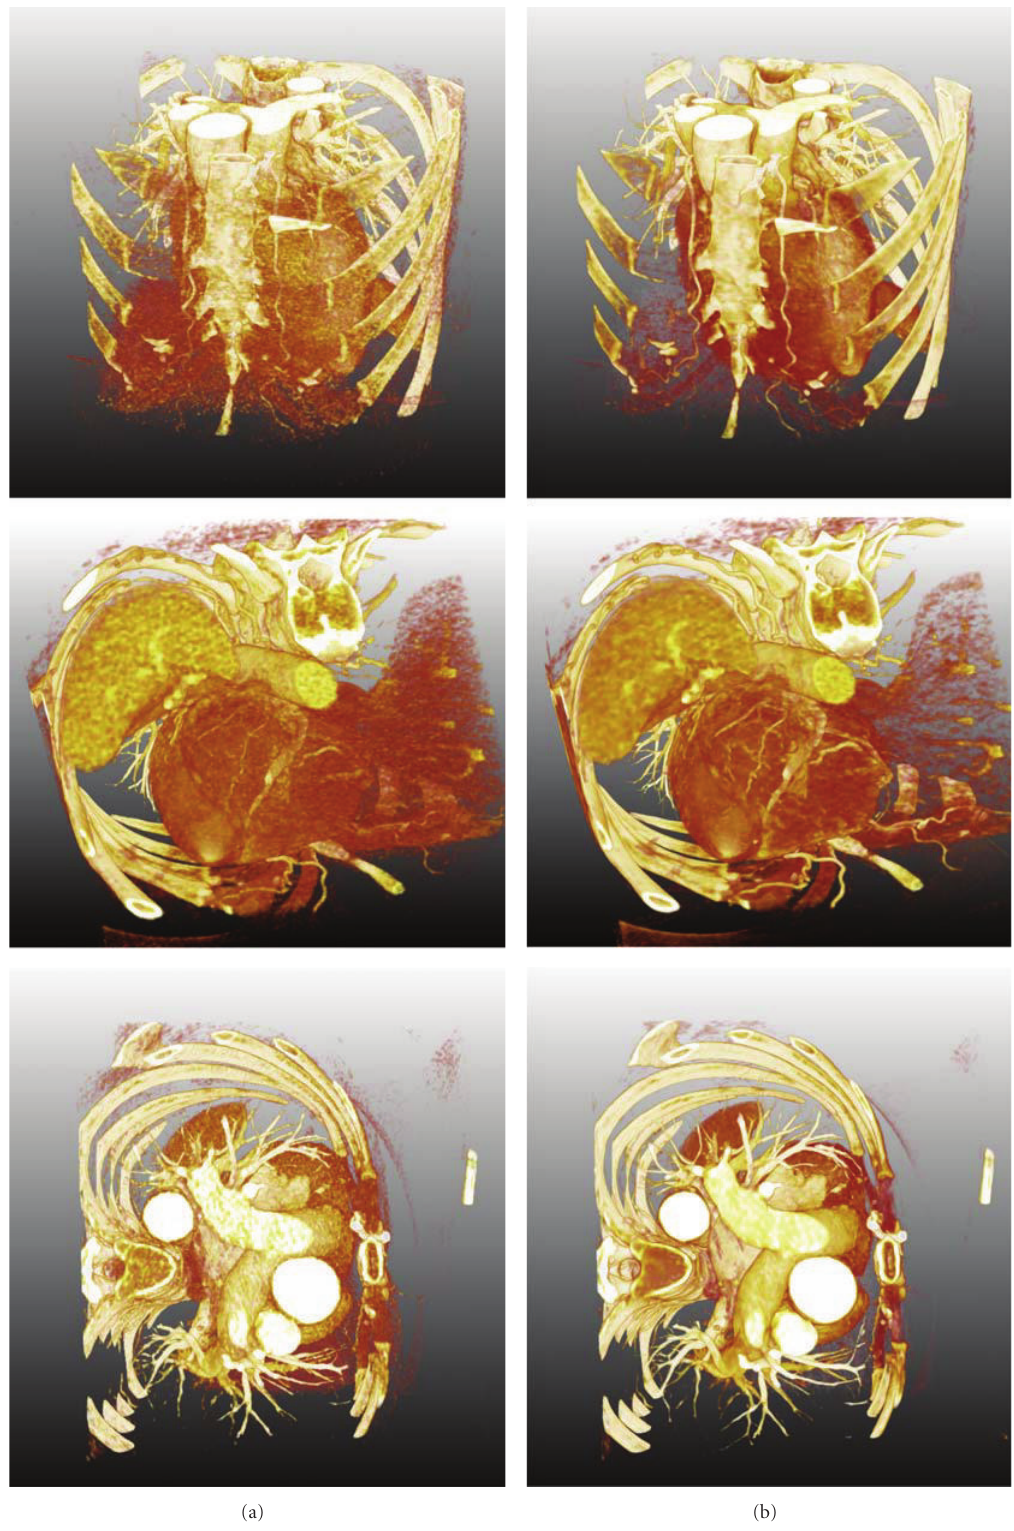
Figure 8: Three comparisons between original CT data (a) and denoised CT data (b). The parameters used for this denoising where α = 0 . 55, β = 1 . 5, and σ = 0 . 1 for the